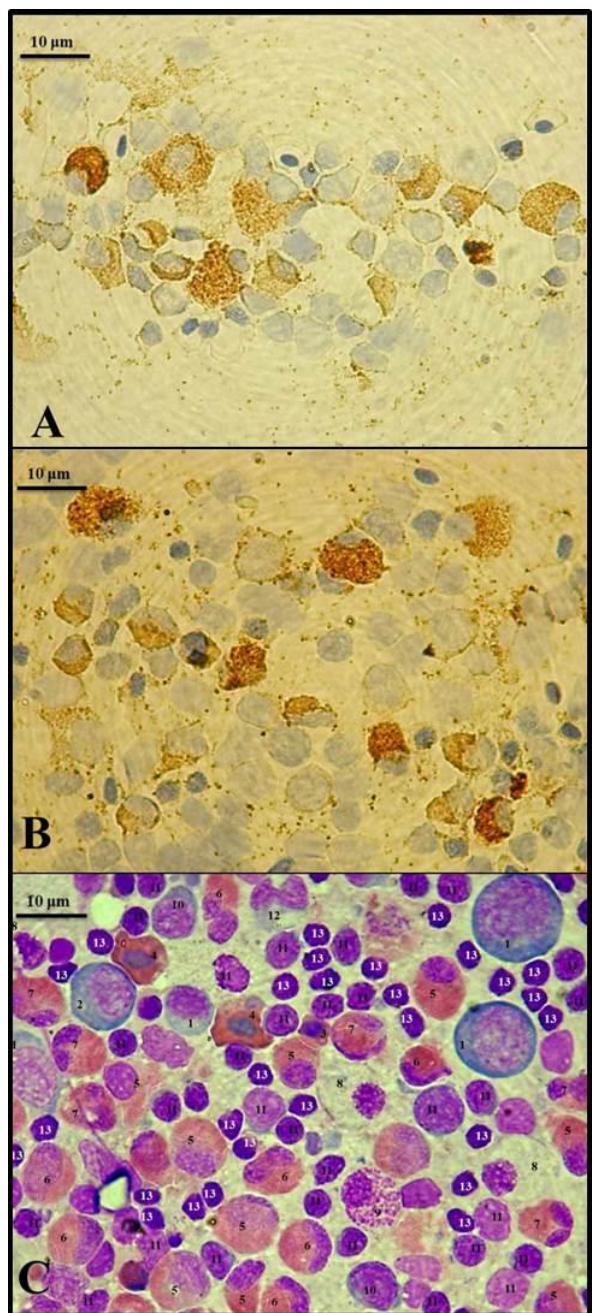
Figure 1. Blood cells in Cyprinus carpio head kidney: ( A )—PCNA-positive cells, ( B )—Caspase 3-positive cells (stained brownish, immunocytochemical staining), ( C )—May–Grünwald and Giemsa